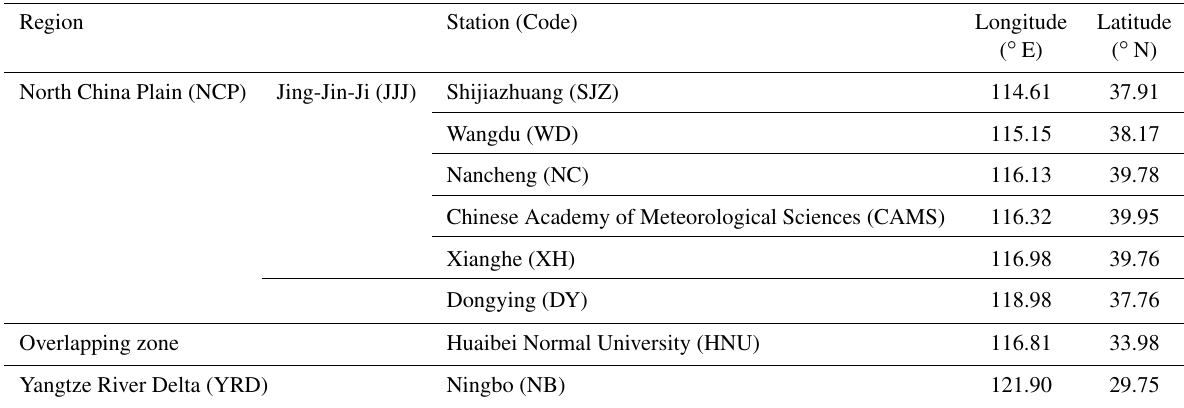
Table 1. The names (codes), latitudes, and longitudes of stations and their corresponding regions. Region Station